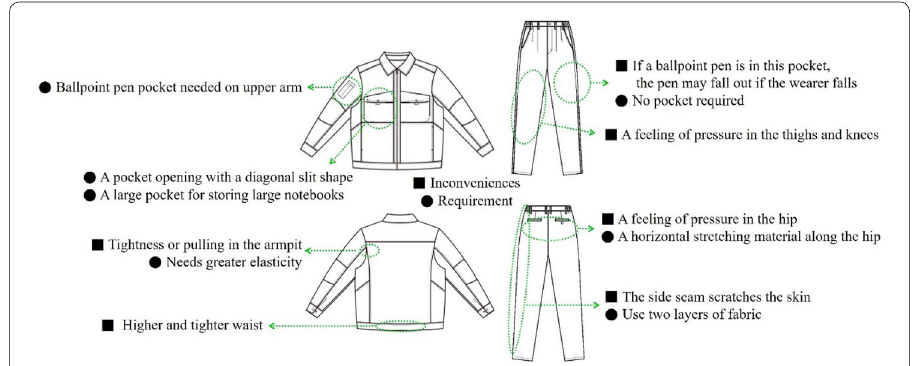
Fig. 2 Design requirements for current workwear